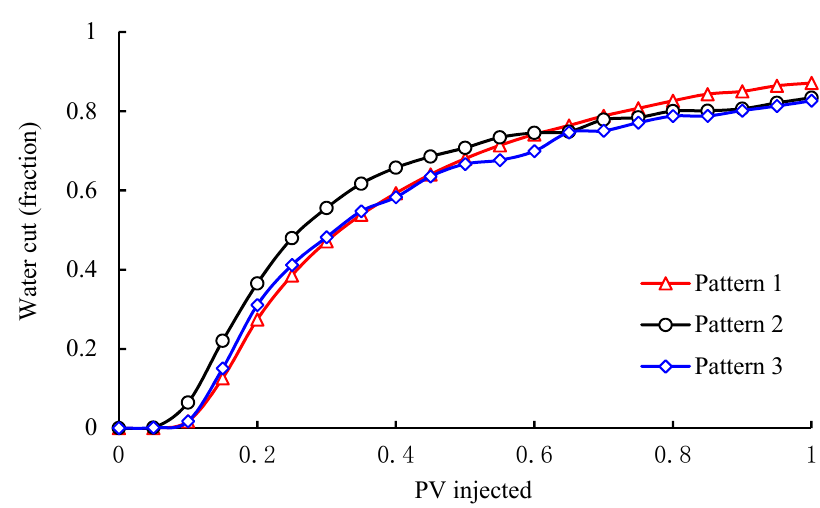
Figure 15. Water cut curve under different fracture spacing patterns.